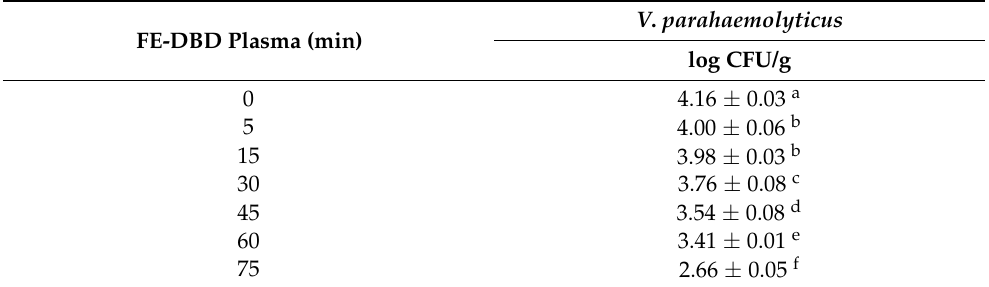
Figure 1. Fitted survival curves of HNoV GII.4 infectivity from FE-DBD plasma-treated sea squirt using the first-order kinetic model. R 2 = correlation coefficient (a higher R 2 value indicates a better fit to the data). Data were represented as mean ± standard deviation of three independent replicates. Table 3. Effect of FE-DBD plasma treatment against V . parahaemoyticus incubated sea